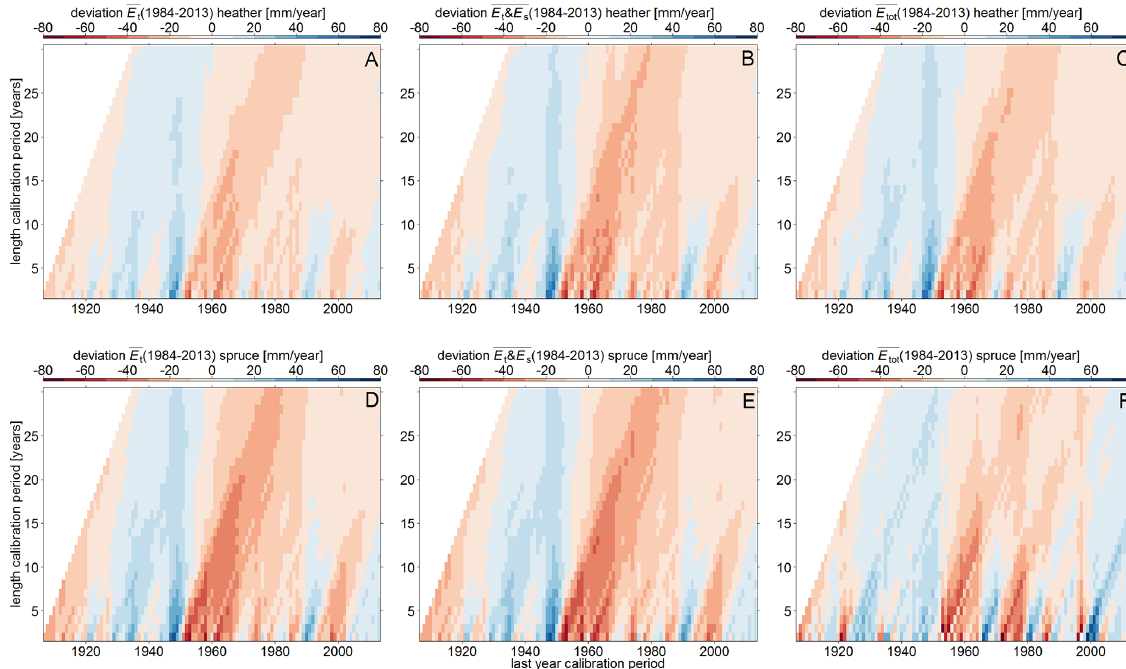
Figure 10. Deviations with synthetic “observations” in E t (left panels), E t & E s (center panels) and E tot (right panels) for the last 30-year period (i.e., 1984–2013), due to different reference years and lengths of calibration periods for both E ref and K t , K ts and K tot . Results for PT and heather (top panels) and spruce (bottom